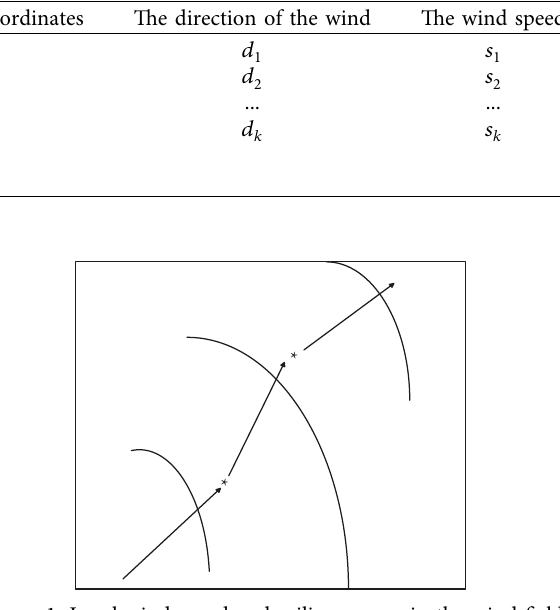
Figure 1: Local wind speed and sailing course in the wind